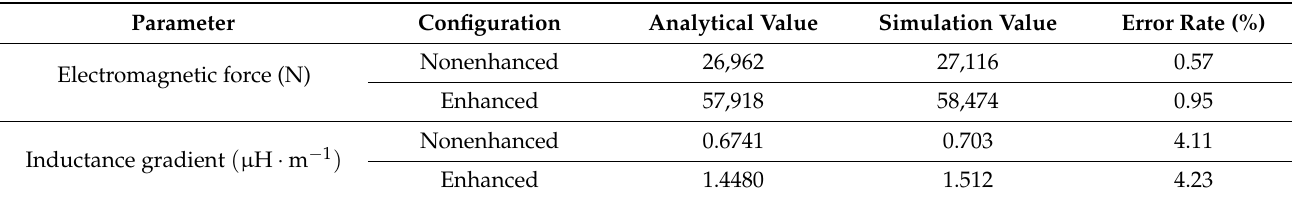
Table 3. Comparison of calculation results of two methods.